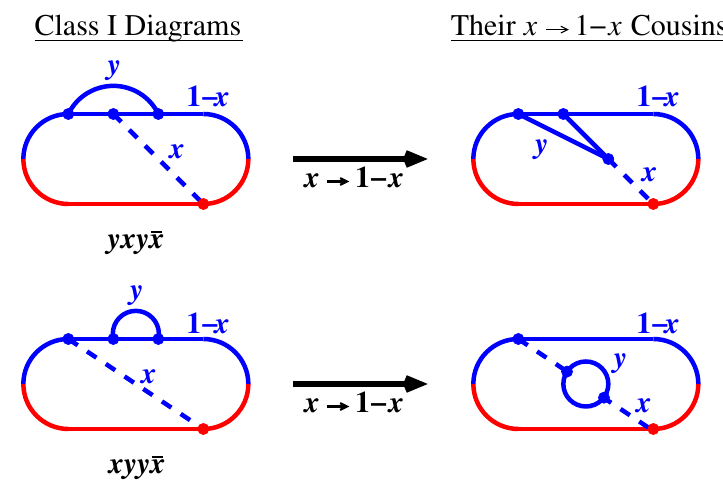
Figure 6 . Two examples of diagrams (right) generated by swapping the two (cid:12)nal-state gluons in Class I diagrams (left) from (cid:12)gure 4. The swap is equivalent to replacing x for Class I diagrams.